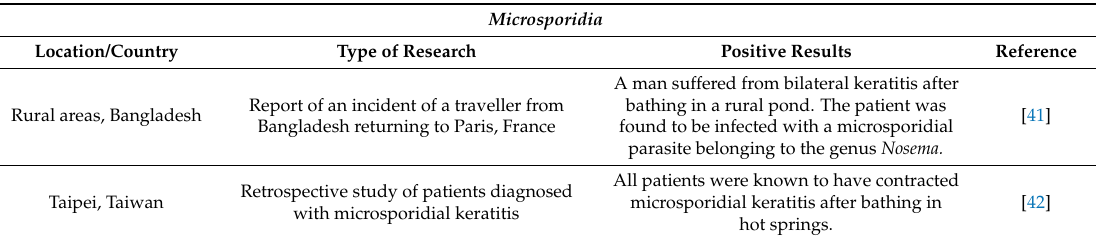
Table 2. List of surveillance studies of swimming pools (SPs), and respective cases and outbreaks of infections associated with swimming pools and hot springs in tropical and subtropical